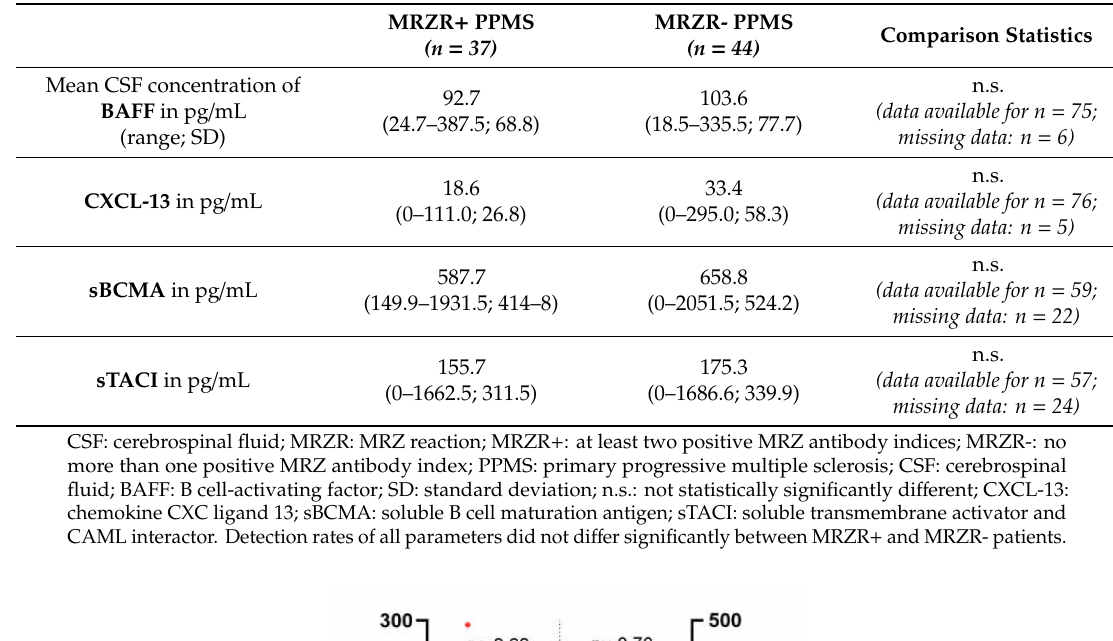
Table 3. B cell biomarkers in CSF.